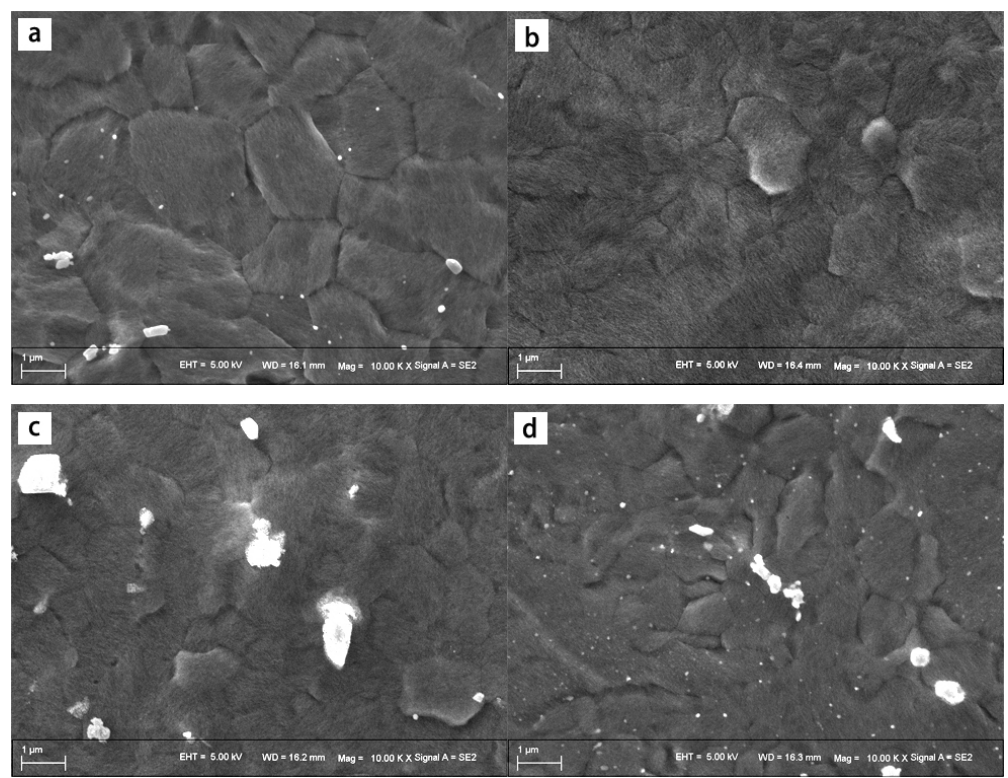
Figure 1. Metallographs of as ‐ extruded ZX30 ( a ), ZK30 ( b ), ZKJ300 ( c ) and ZKXQ3000 ( d ) alloys.